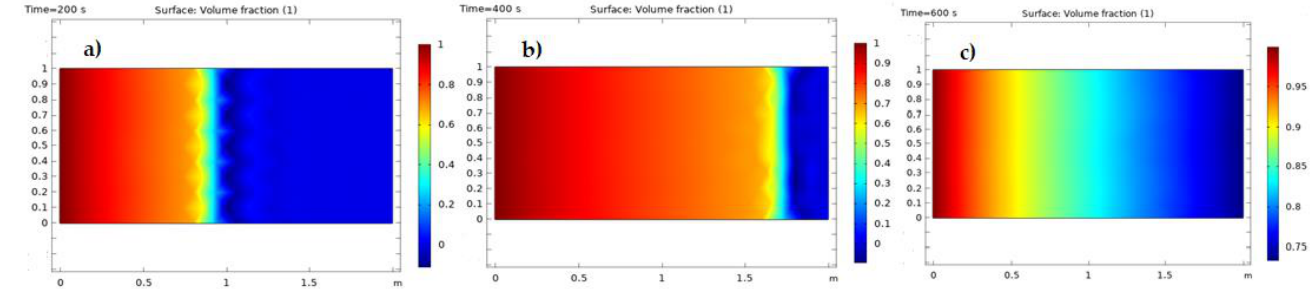
Figure 7. ( a ) Saturation of the nanofluid at 200 s, ( b ) saturation of the nanofluid at 400 s, and ( c ) saturation of the nanofluid at 600 s.